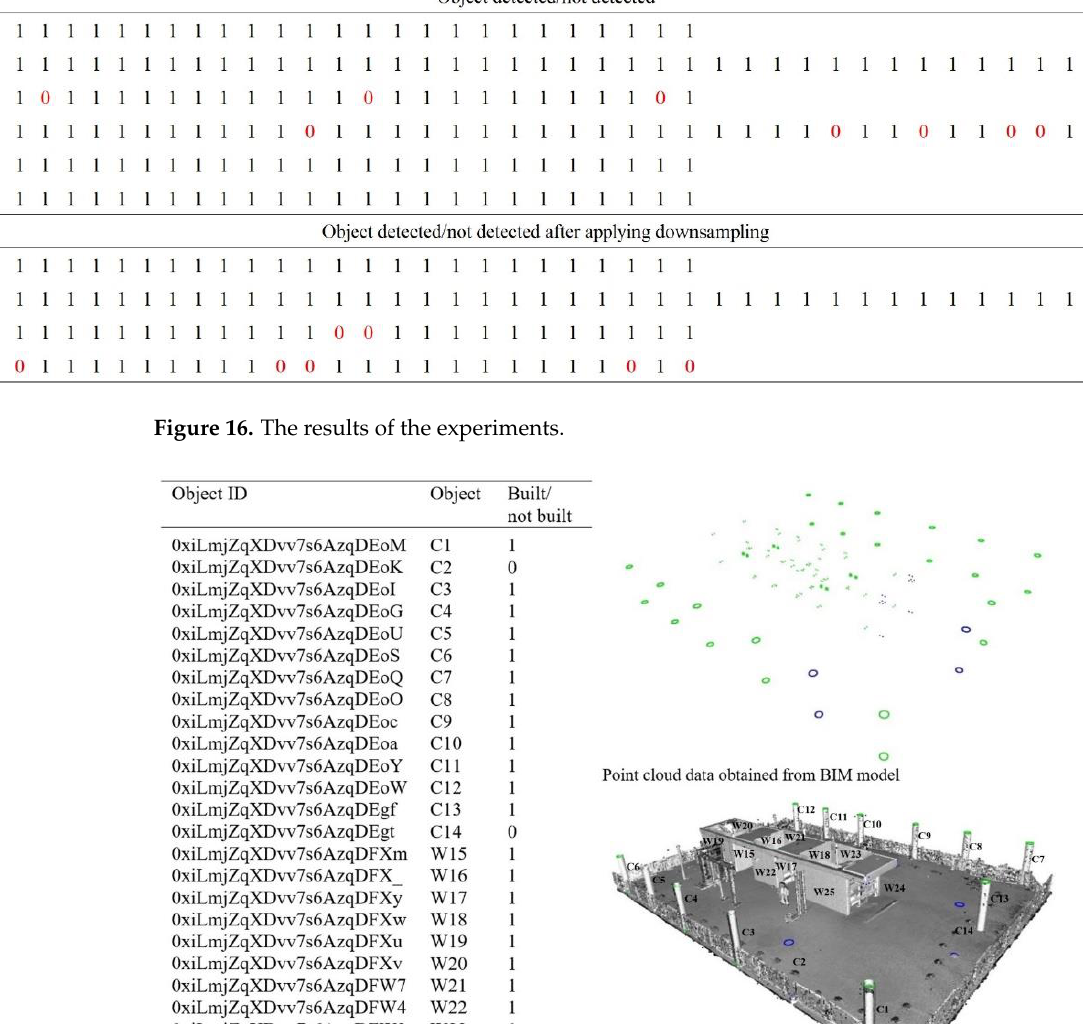
Figure 16. The results of the experiments.